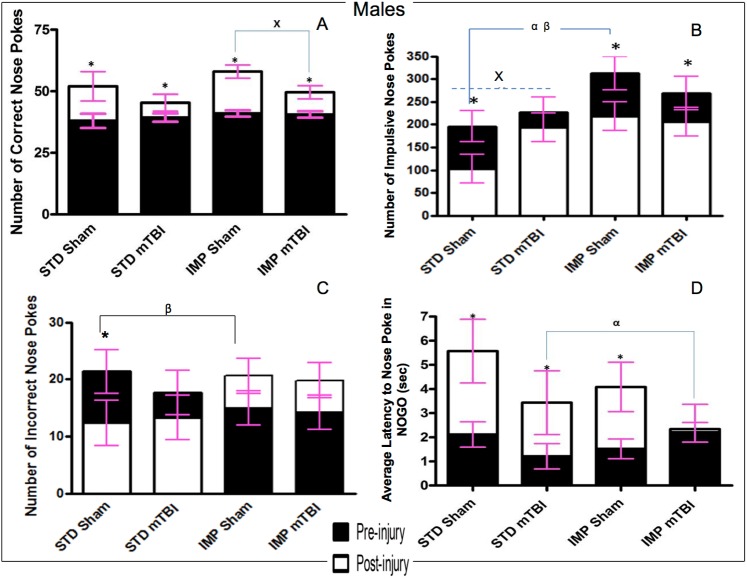
Graphical representation of Go/No-Go results.A) accuracy, B) Impulsivity, C) Inaccuracy, and D) Response Inhibition, for male animals from the STD and IMP cohorts at the pre-injury (black bars) and post-injury (white bars) test sessions. Overall accuracy increased across all cohorts from the pre-injury session to the post-injury session, but the magnitude of change was greater for sham animals. Males in the STD cohort exhibited a reduction in incorrect nose pokes with increased training but animals in the IMP cohort actually exhibited an increase in incorrect nose pokes. Cohort and mTBI increased impulsivity when compared to STD-sham animals. Finally, all males except IMP-mTBIs demonstrated improvements in latency to nose poke on the NOGO trials, but again the magnitude was greatest for STD-shams (α significant effect of IMP at pre-injury, β significant effect of IMP at post-injury, x significant effect of mTBI, * significant effect of testing period, all p < .05).